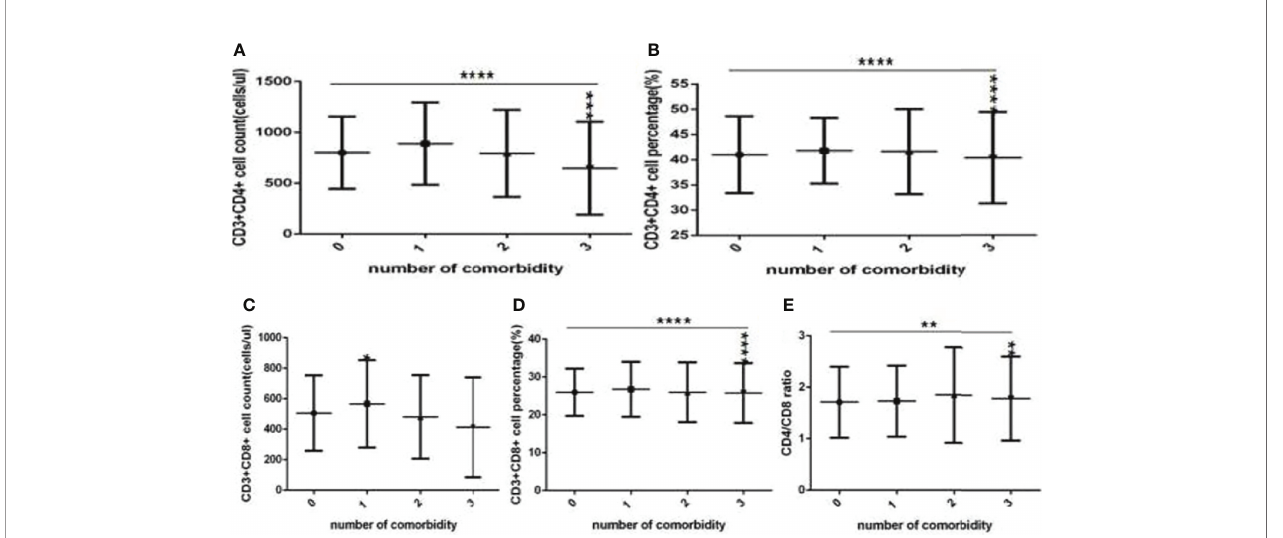
FIGURE 7 | Comparison of T cell subset counts and percentages among the different numbers of comorbidities ( n =718; 0, 1, 2, 3 or more comorbidity groups, n =253, 193, 127 and 145 cases, respectively). COVID-19, coronavirus disease 2019. NAFLD, nonalcoholic fatty liver disease. DM, diabetes mellitus. CHB, chronic hepatitis (B) COPD, chronic obstructive pulmonary disease. CKD, chronic kidney disease. CVD, cardiovascular disease. (A) CD3+CD4+ cell count. (B) CD3+CD4+ cell percentage. (C) CD3+CD8+ cell count. (D) CD3+CD8+ cell percentage. (E) Ratio of CD4+/CD8+ cells. Unpaired one-way ANOVA was used for intergroup comparisons ( A, B, D , P all <0.0001; E , P < 0.01; C , P > 0.05). Unpaired t -tests were used for comparisons with the no comorbidity group, * P < 0.05, ** P < 0.01, *** P < 0.001, **** P <